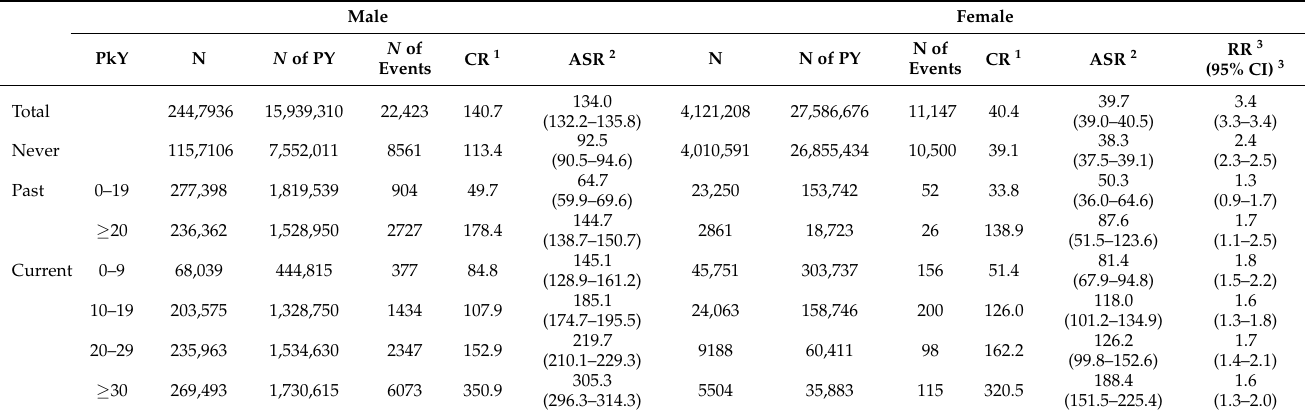
Table 2. Incidence of lung cancer by sex and smoking status at baseline.